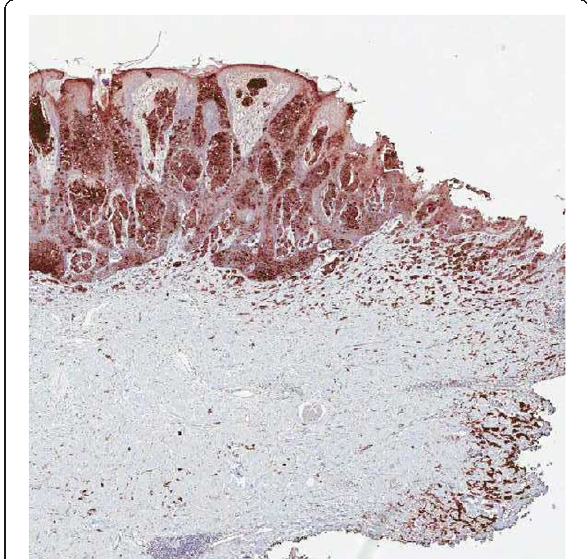
Figure 6 Skin and subcutis showing hyperplastic epidermis